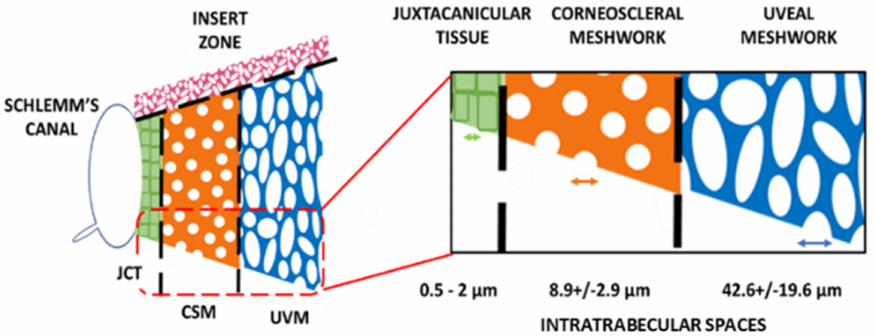
Figure 10. Schematic diagram of the structure of the trabecular meshwork and its four main regions: the uveal meshwork (UVM), corneoscleral meshwork (CSM), the juxtacanicular tissue (JCT) and the insert zone. The insert zone is where progenitor cells reside within the TM. The other zones constitute the “filtering region” of the TM. The dimensions of the intertrabecular spaces in the filtering region of the TM were taken from King et al., (2019) and dimensions of intratrabecular spaces of the JCT are as reviewed in Crouch et al., (2021)